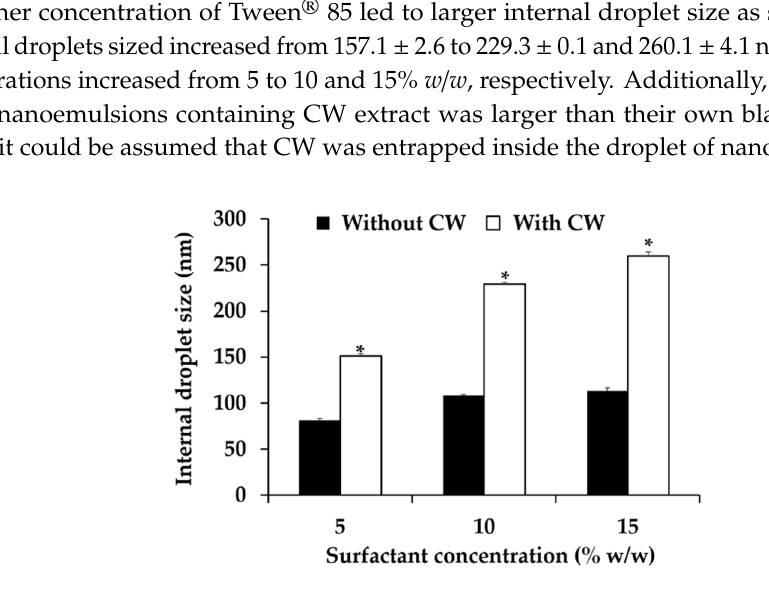
Figure 11. Internal droplet size of nanoemulsions with and without CW. Asterisk (*) denoted significant difference between nanoemulsions with and without CW analyzed using t-test ( p < 0.05).